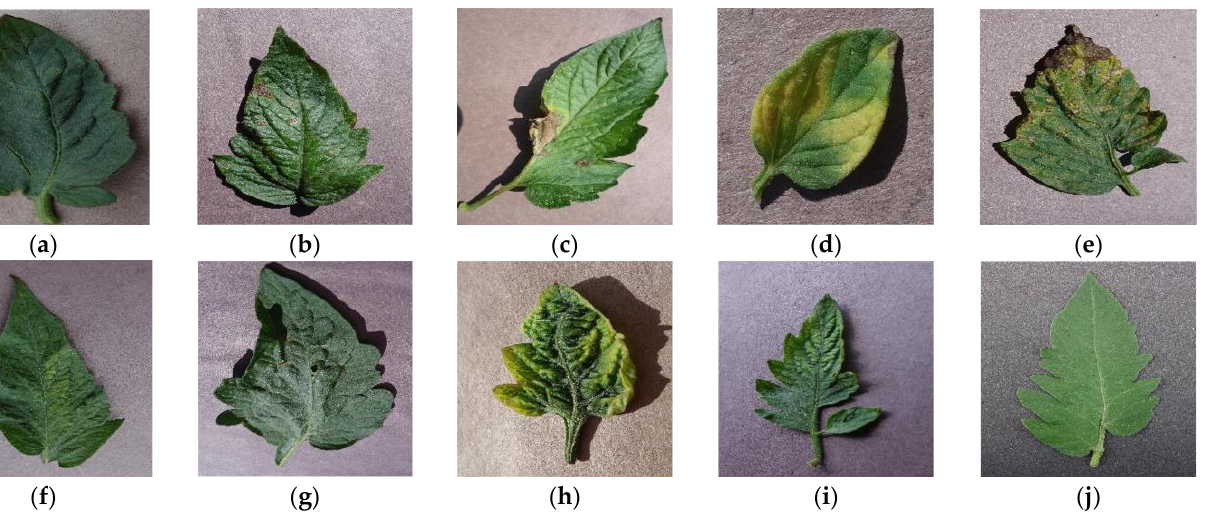
Figure 3. Ten samples of tomato leaf disease and healthy images: ( a ) Bacterial spot disease; ( b ) Early blight disease; ( c ) Late blight disease; ( d ) Leaf mold disease; ( e ) Septoria leaf spot disease; ( f ) Two- spotted spider mites; ( g ) Target spot disease; ( h ) Yellow leaf curl virus disease; ( i ) Mosaic virus disease; ( j ) Healthy.